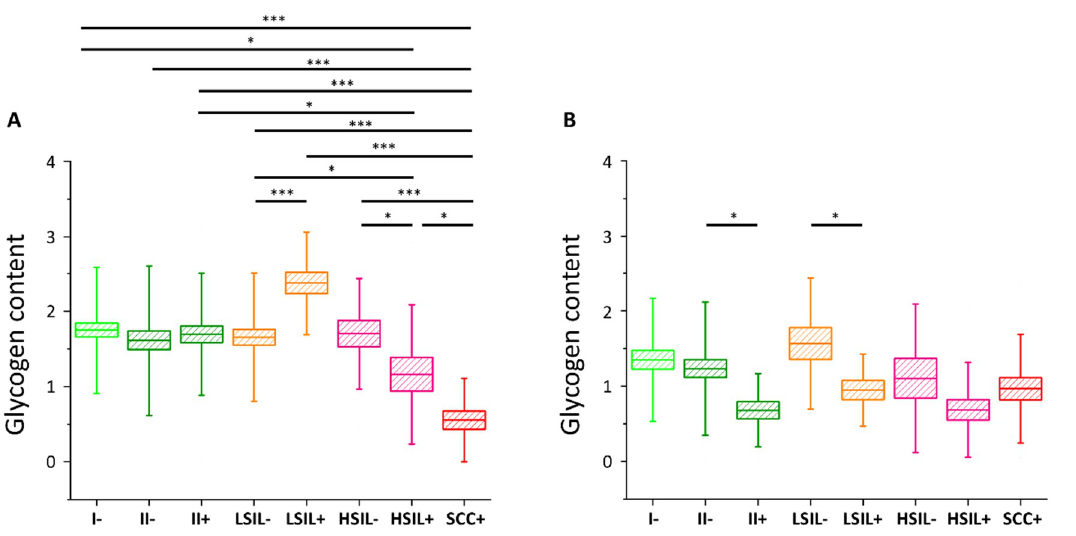
Figure 3. Glycogen content in the cytoplasm of cervical epithelial cells depending on HPV presence . The comparison of the glycogen content in the cytoplasm of cervical epithelial cells in studied groups: I / HPV − (bright green), IIa / HPV − (dark green), IIa / HPV + (dark green), LSIL / HPV − (orange), LSIL / HPV + (orange), HSIL / HPV − (pink), HSIL / HPV + (pink), SCC / HPV + (red) obtained by calculations of the integral intensity of the band at 486 cm − 1 for cells with the nuclei of a diameter < 10 µ m ( A ) and ≥ 10 µ m ( B ). Mean values ± SEM are given as box plots: mean (horizontal line), SEM (box), SD (whiskers). * p < 0.05, *** p < 0.001 (only key significances, described in the text, were presented).